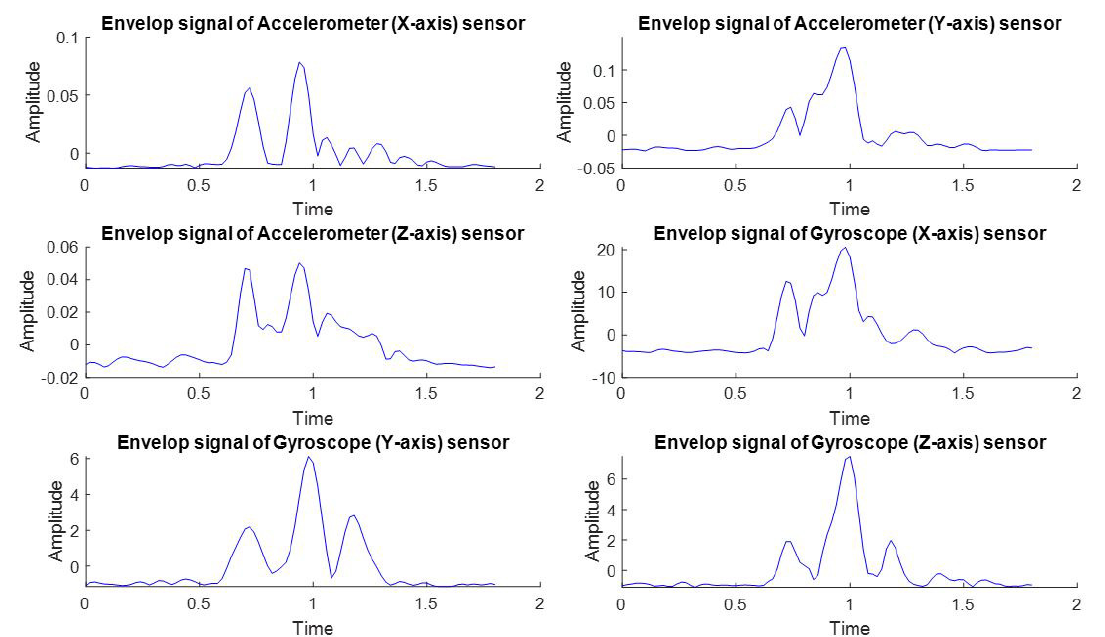
Figure 10. Examples of envelop signal of accelerometer and gyroscope sensor.